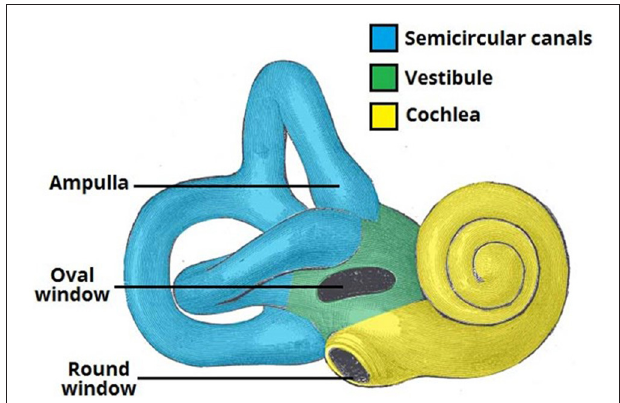
FIGURE 1 | Structure of the inner ear of